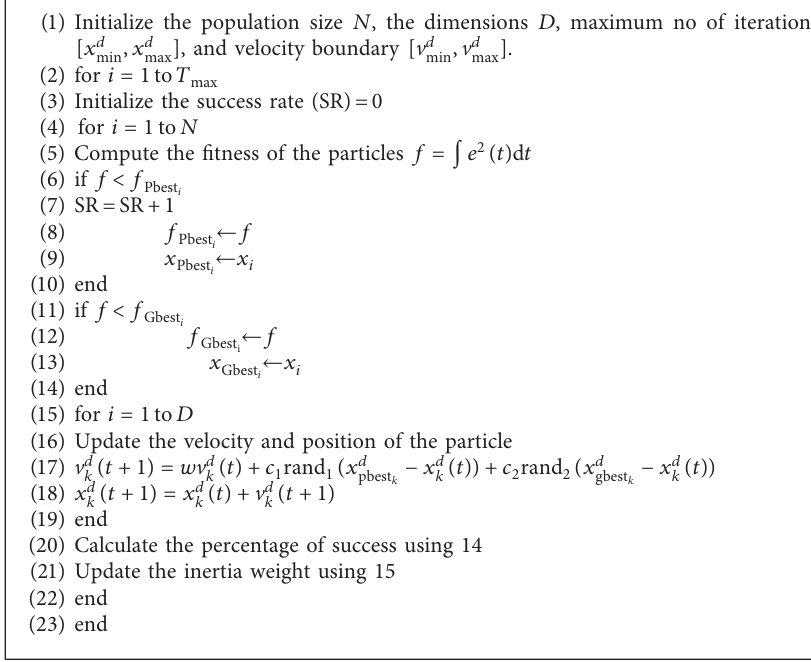
A LGORITHM 1: AIWPSO